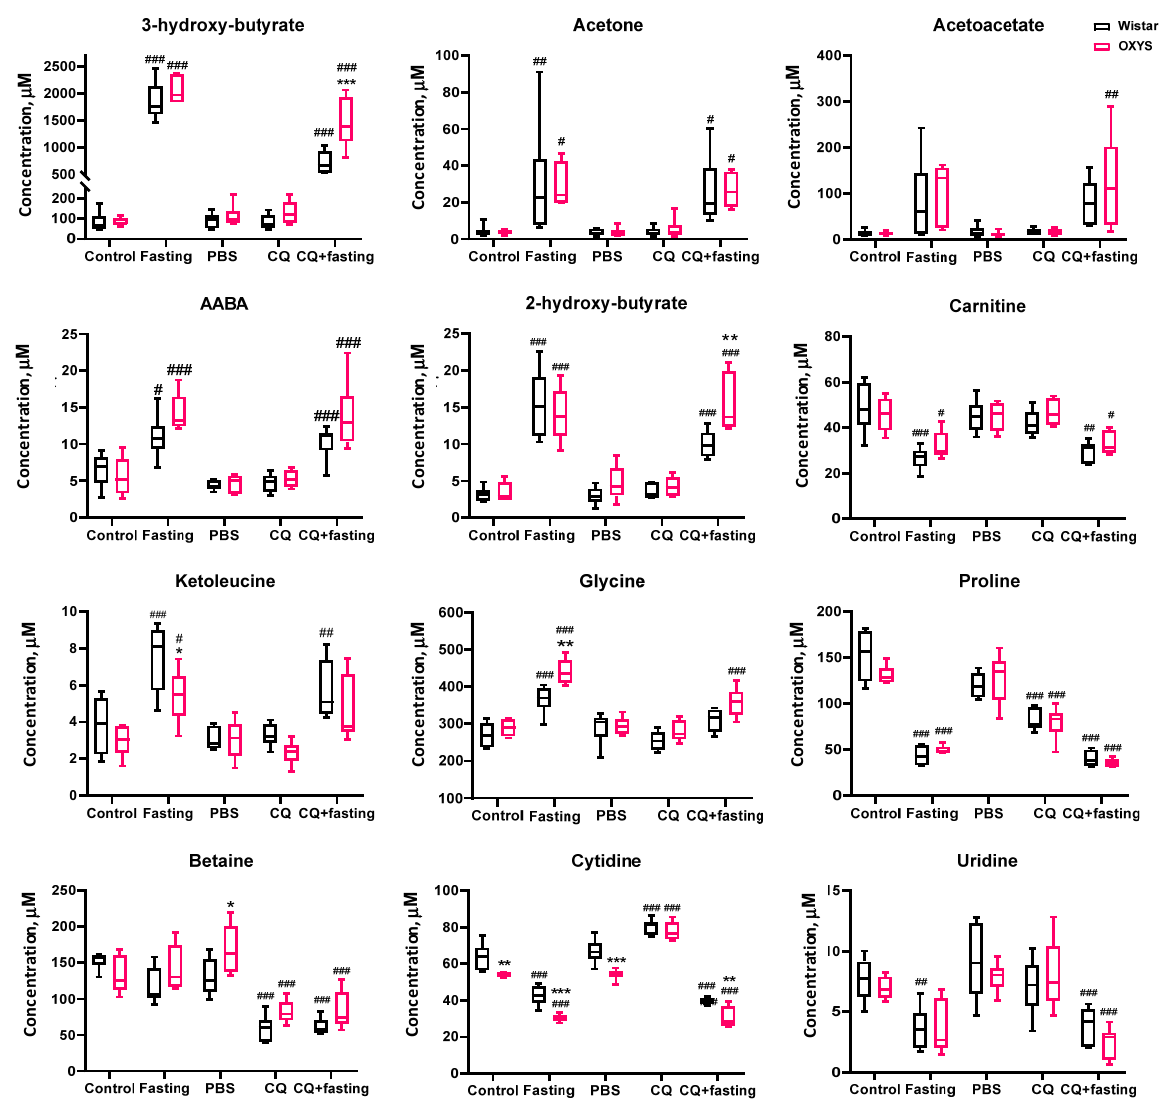
Figure 4. Concentrations of some serum metabolites for Wistar (black boxes) and OXYS (pink boxes) rats under autophagy modulation by 48 h fasting, chloroquine (CQ) treatment, and combined effects of fasting and CQ. The complete set of boxplots of altered serum metabolites is given in Figure S3. Data presented by boxplots: medians, the 25–75% interquartile range (bars), and min–max (error bars). Intact control serves as a control group in the case of fasting, and phosphate-buffered saline (PBS) group serves as a vehicle control to CQ and CQ + fasting treatment groups. Notation means: * p < 0.05, ** p < 0.01, *** p < 0.001 OXYS vs. Wistar rats from the same treatment group; # p < 0.05, ## p < 0.01, ### p < 0.001 vs. control group (intact control in the case of fasting, PBS vehicle control in the case of CQ/CQ + fasting) within the same strain of rats, post hoc comparisons after ANOVA or Kruskall–Wallis test.